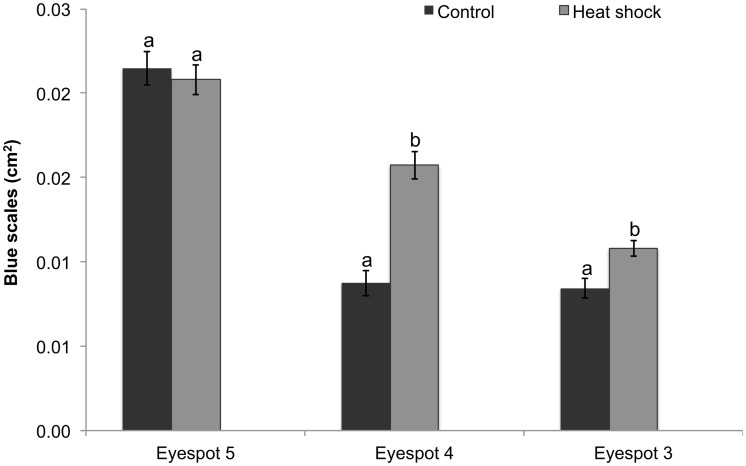
Area of blue scales across all four eyespots in the different treatments.Data represent the area in cm2 with error bars representing 1 SE from the mean. The 2-way ANCOVA was performed on square-root transformed data. Results shown in Table 1. Different letters above the bars indicate significant differences within each individual eyespot.